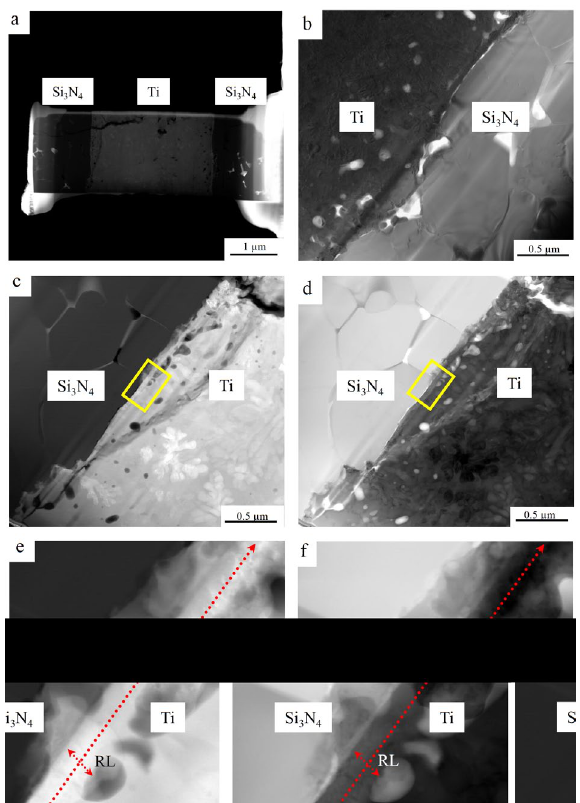
Fig. 2 (a, c, e) STEM − HAADF images of HT and FIBed Si 3 N 4 − Ti sample, (b) zero loss images of FIBed Si 3 N 4 − Ti joints, and (d, f) BF images of Si 3 N 4 –Ti